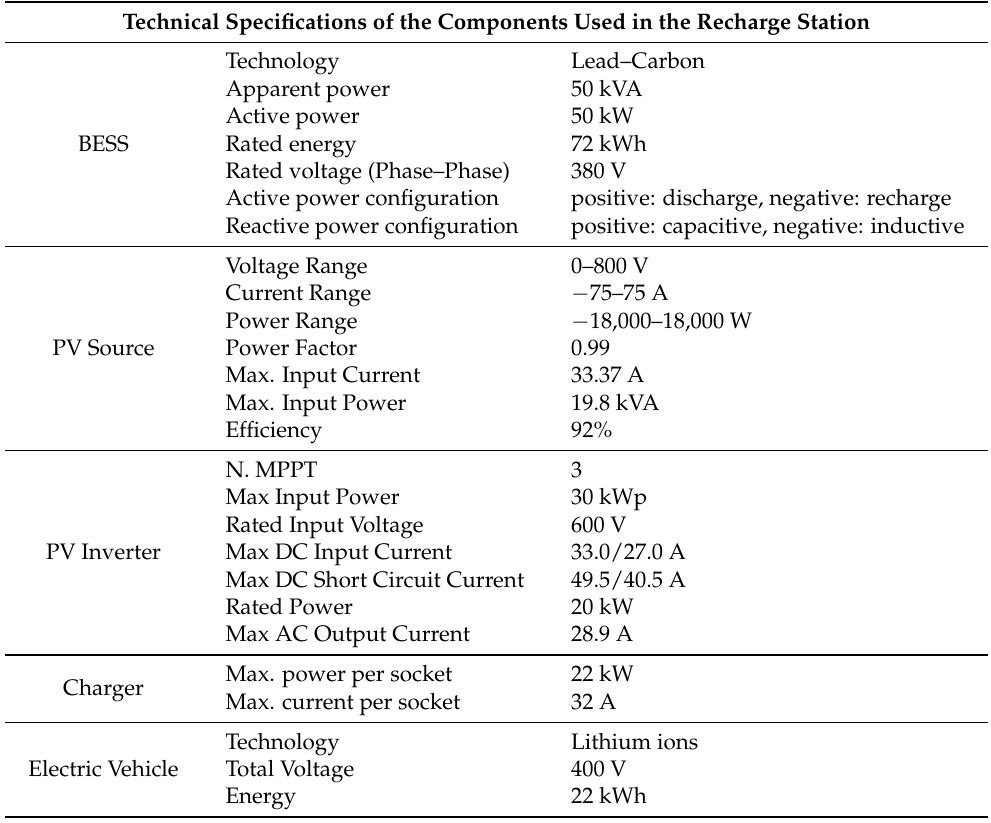
Table 1. Simplified technical specifications of the components used in the Recharge Station. Technical Specifications of the Components Used in the Recharge